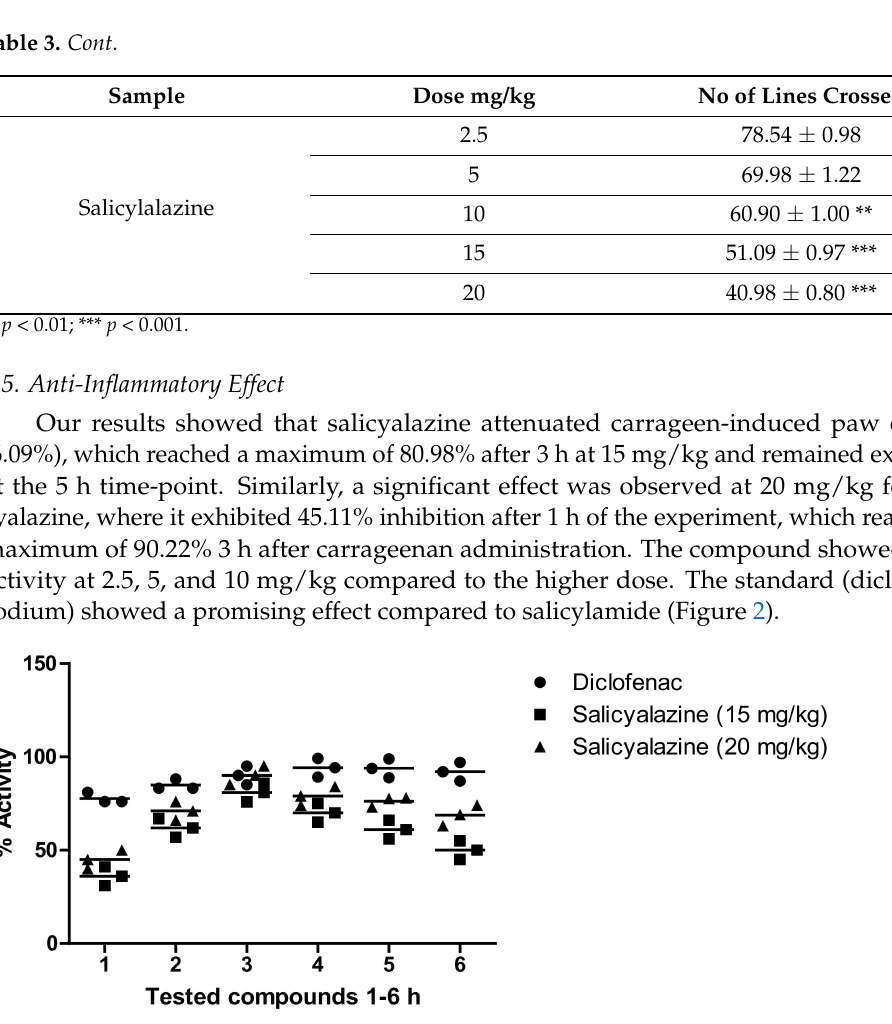
Figure 2. Anti-inflammatory potential of salicyalalzine (15, 20 mg/kg) of the M. biflora on carrageenan paw in mice. The obtained results are shown as ± S.E.M for six groups of animals. In the histamine- induced paw edema model, salicylalzine (15 mg/kg) showed 78.45% and 74.33% effects in the initial phase (at 1 and 2 h time points) and was continued up to the second phase (58.09%) at 3 h. An excellent effect (90.55% and 93.99%) was observed at 20 mg/kg at the 1 h and 2 h time points, respectively, while it reached 86.11% after 3 h (Figure 3).